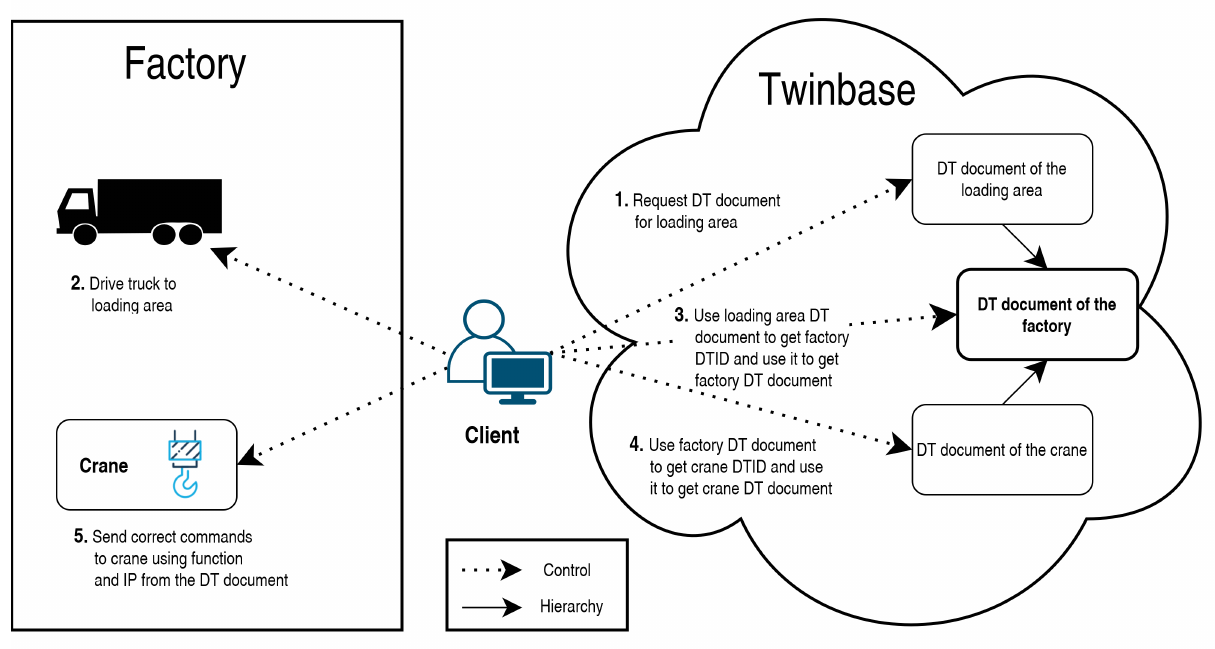
Figure 6. Practical example of applying Twinbase to find entities in the same operating